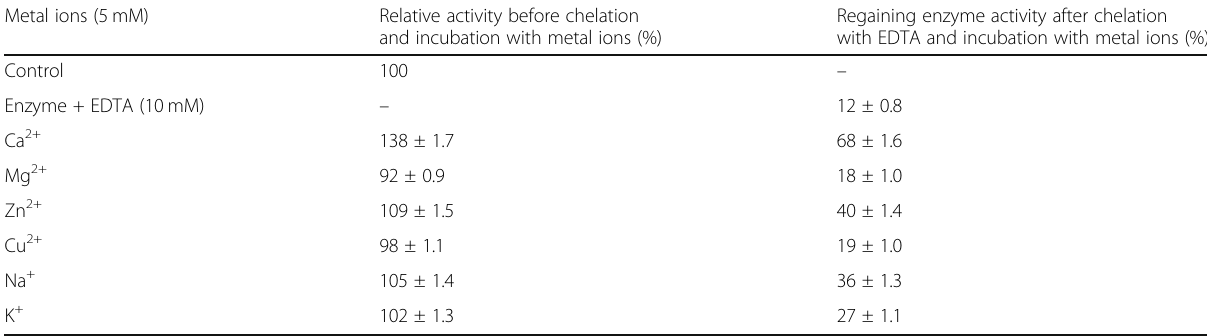
Table 4 Effect of metal ions on serratiopeptidase activity Metal ions (5